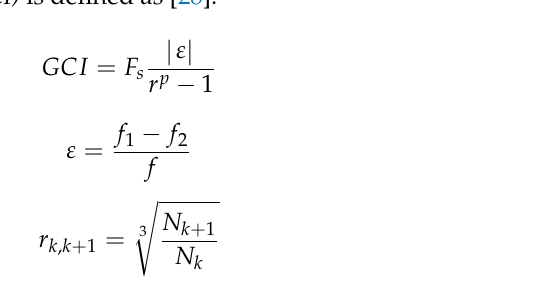
Figure 3. Grid independence test. The grid convergence index ( GCI ) was used to quantify the grid independence. Re- place Nos. 1, 2, 3, 4, and 5 with 1.09 million, 1.41 million, 1.91 million, 2.32 million, and 2.74 million, respectively.